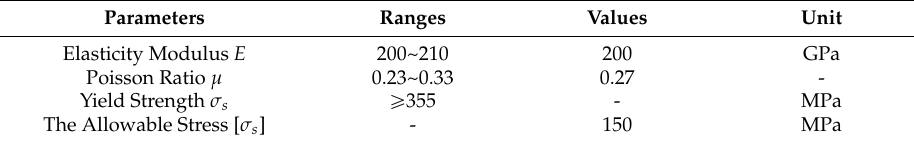
Table 2. The pillar material constants.